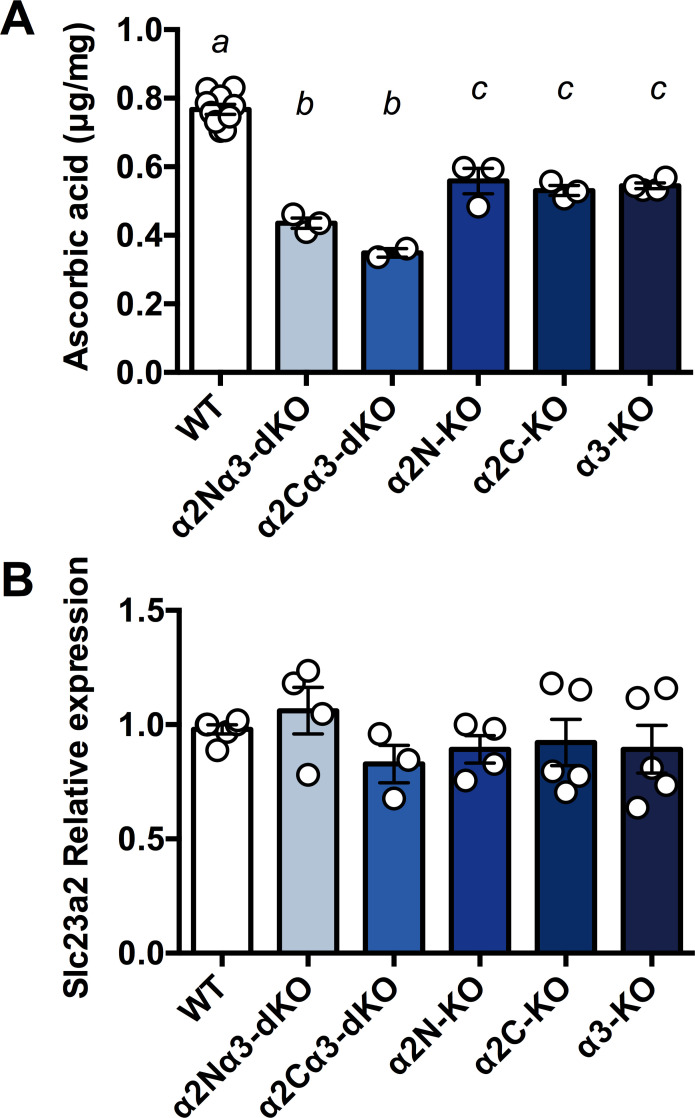
Ascorbic acid (ASC) content and Slc23a2 expression in the whole foetal brain.A. The ASC content in the whole brains isolated from foetuses was measured using HPLC with chemical detection. α2N/α3-dKO, a double homozygous knockout of Atp1a2N/Atp1a3; α2C/α3-dKO, a double homozygous knockout of Atp1a2C/Atp1a3; α2N-KO, a homozygous knockout of Atp1a2-N; α2C-KO, a homozygous knockout of Atp1a2-C; α3-KO, a homozygous knockout of Atp1a3. Values for WT from separate litters were combined for analyses. Data were analysed using univariate ANOVA with Tukey post hoc follow-up analyses, corrected for multiple comparisons. Bars marked with separate letters are significantly different from each other (P<0.05), except in one case, i.e., α2Nα3-dKO vs. α2C-KO where the trend was not significant (P = 0.085). a vs. b & a vs. c P<0.001, b vs. c P<0.05. Data are presented as the mean ± SE. B. Relative mRNA expression of Slc23a2 in whole brains isolated from foetuses. The expression level in one of WT brains was set as 1.0 in three independent experiments. No significant differences were observed among genotypes.